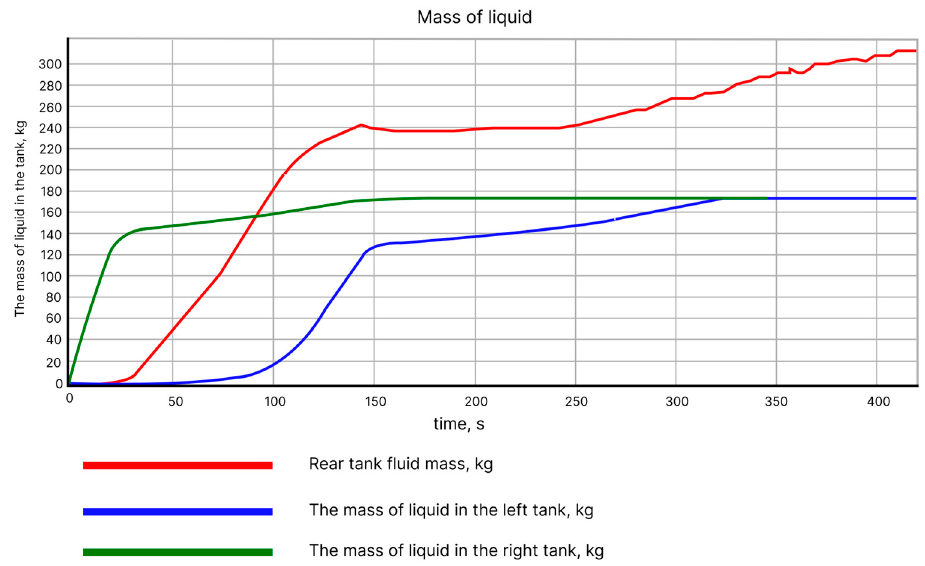
algorithm simulating the float valve controls the fuel level in the tank (for continuous filling, it is recommended to refine the float valve model).